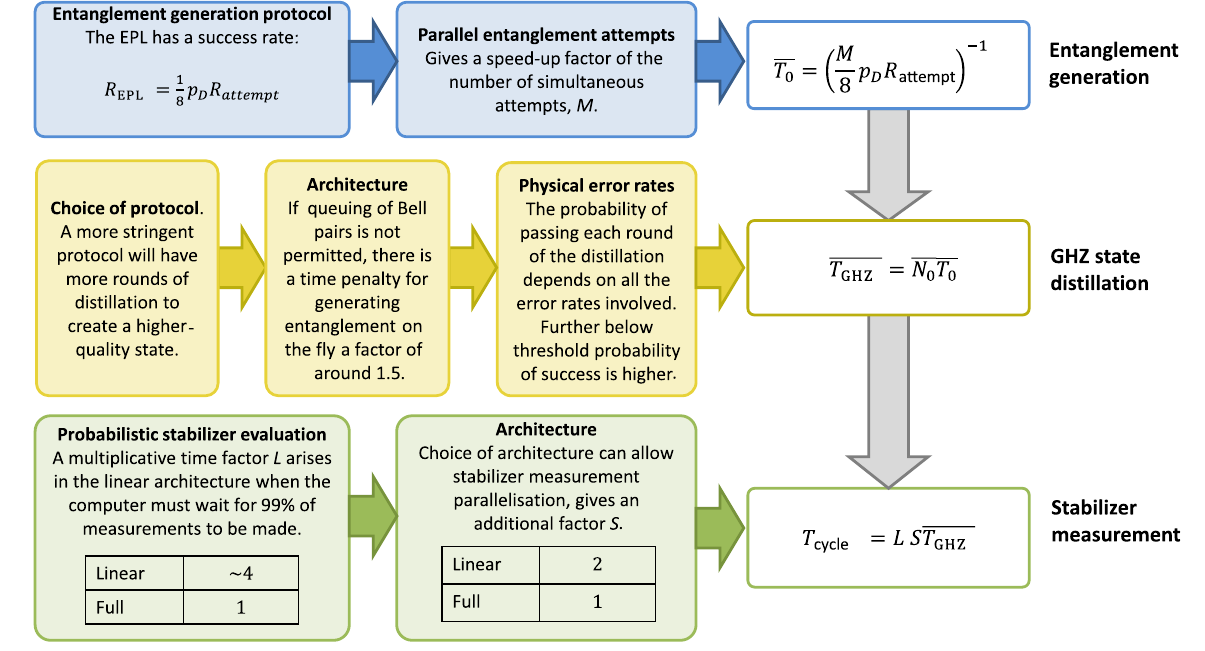
refined.FIG. 8. The seven major factors contributing to the overall potential running speed of the